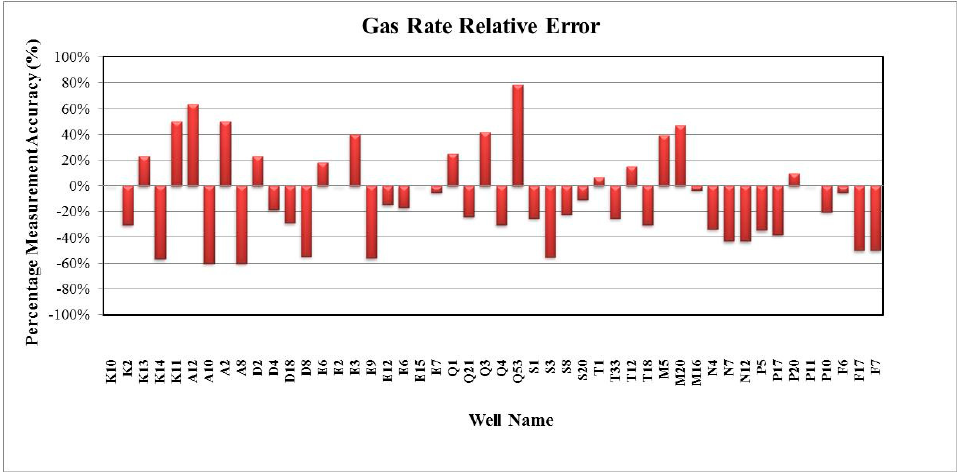
Figure 24. Water rate measurement accuracy using the Colebrook correlation. Energies 2018 , 11 , x FOR PEER REVIEW 19 of 23